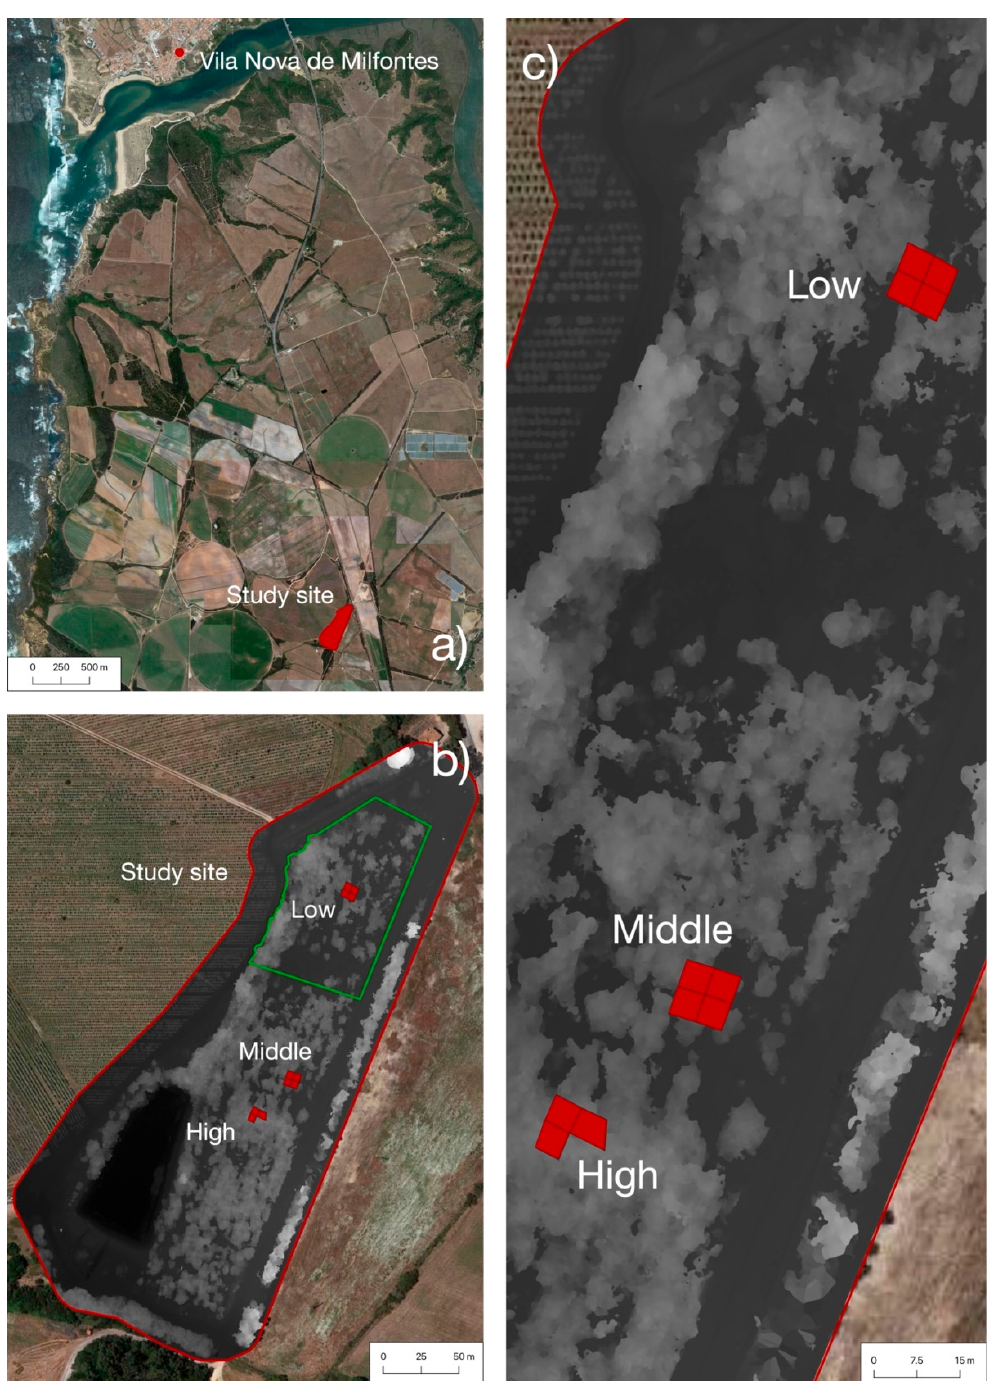
Figure 5. Zoom in on the study area. ( a ) Overview of the area surrounding the study site, which is situated in an agricultural area south of Vila Nova de Milfontes, Odemira, Portugal. ( b ) Close up of study site (marked in red), indicating the 3 different sampling sites (red boxes, density indicated in white letters) and the total biomass harvested (area outlined in green). ( c ) Zoom in on the sampling sites. Zoom ( b , c ) are with overlay of the digital terrain model (in tones of grey, darker grey indicates lower areas, and lighter grey higher areas).